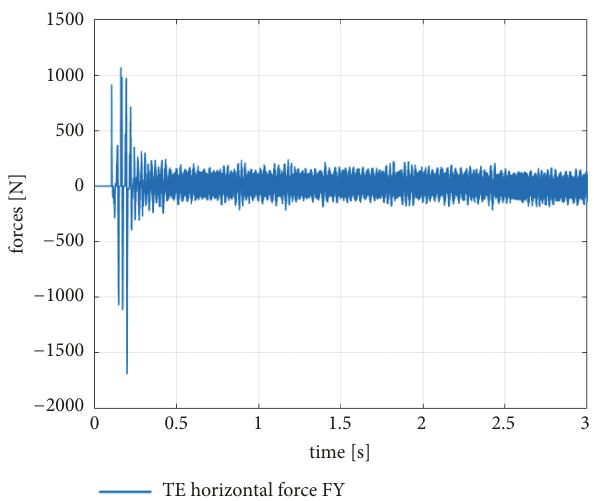
Figure 15: Predicted rotor horizontal forces during a landing test (DE